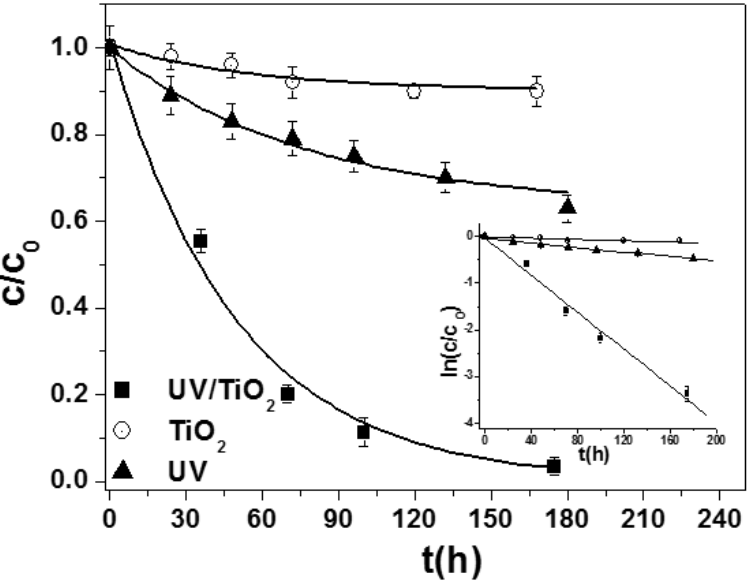
Figure 5. Kinetic trends for the UV/TiO 2 photo-catalysis (test no. 10), UVB photolysis (test no. 14), adsorption (only TiO 2 , test no. 15), MO = 0.7 mg/L; TiO 2 = 0.79 g/cm 3 ; Q = 0.305 L/s; h w = 13.5. In the inset: lnc/c 0 vs. t correlations.